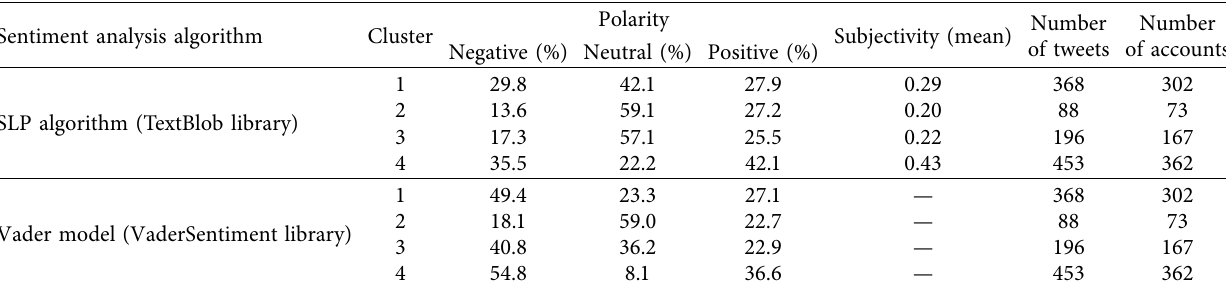
Figure 4: Word map for the clusters of Scenario 1. Table 4: Sentiment analysis results for Scenario 1 using SLP algorithm versus Vader model.